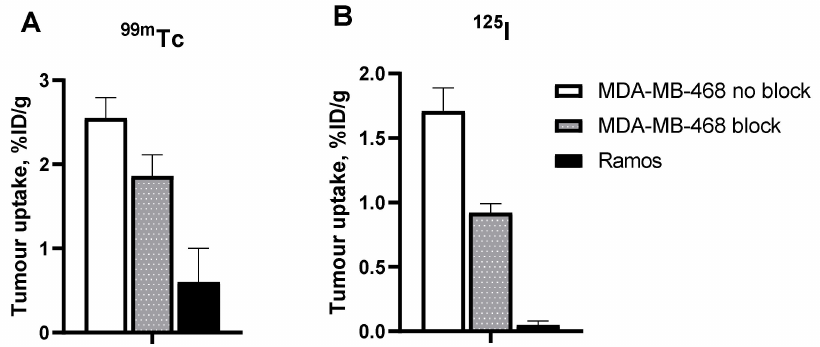
Figure 5. In vivo specificity of EpCAM targeting using [ 99m Tc]Tc(CO) 3 -Ec1 ( A ) and [ 125 I]I-PIB-Ec1 ( B ). Uptake of both DARPin variants was significantly ( p < 0.01, unpaired t -test) higher in EpCAM-positive MDA-MB-468 xenografts than in EpCAM-negative Ramos xenografts 6 h post injection (pi). EpCAM blocking in MDA-MB-468 xenografts by co-injecting a large excess of unlabeled Ec1